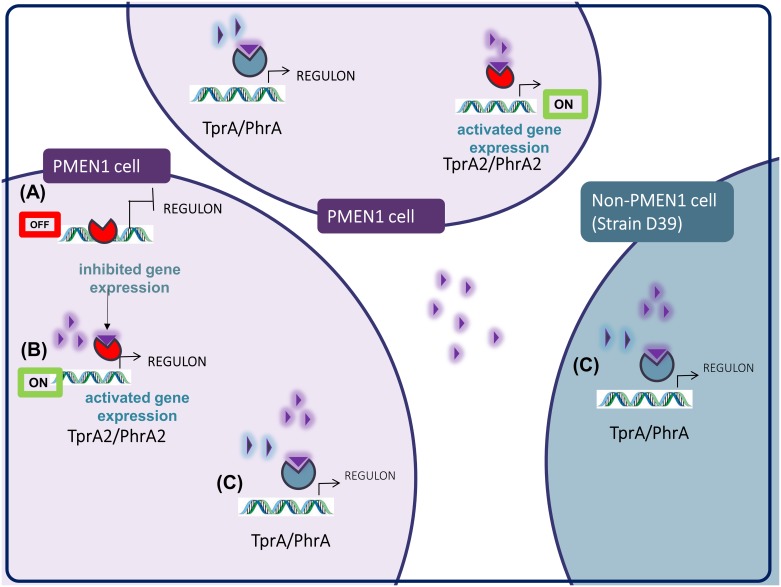
Model for regulation of gene expression by TprA2-PhrA2.(A) In the OFF state, TprA2 inhibits gene expression. (B) In the ON state, PhrA2 releases TprA2-mediated gene inhibition. This effect of PhrA2 is observed from synthetic peptide added to the extracellular milieu and cell-free supernatant, suggesting that PhrA2 is exported, activated and re-imported before it modulates TprA2 activity, in both the producer PMEN1 cells and surrounding PMEN1 population. (C) PhrA2 secreted by PMEN1 cells activates gene expression of tprA and associated lanA, in both PMEN1 and non-PMEN1 cells. Red circular shape/TprA2, purple triangle/PhrA2, blue circular shape/TprA; blue triangle/PhrA.